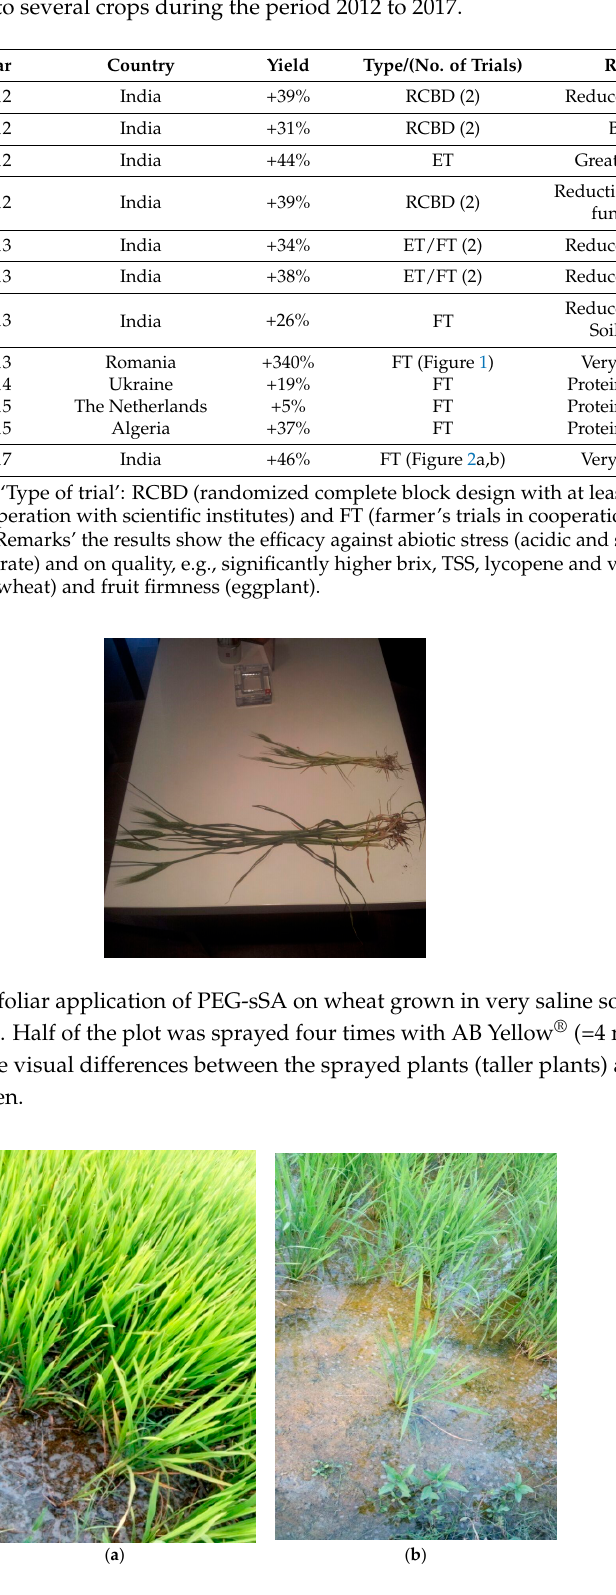
Figure 2. Rice plants grown on very acidic soil on a plot of 1.5 ha near Chennai (India), 2017. Half of the plot was sprayed with PEG-sSA. The visual differences between sprayed plants (a) and the control (b) can be seen.